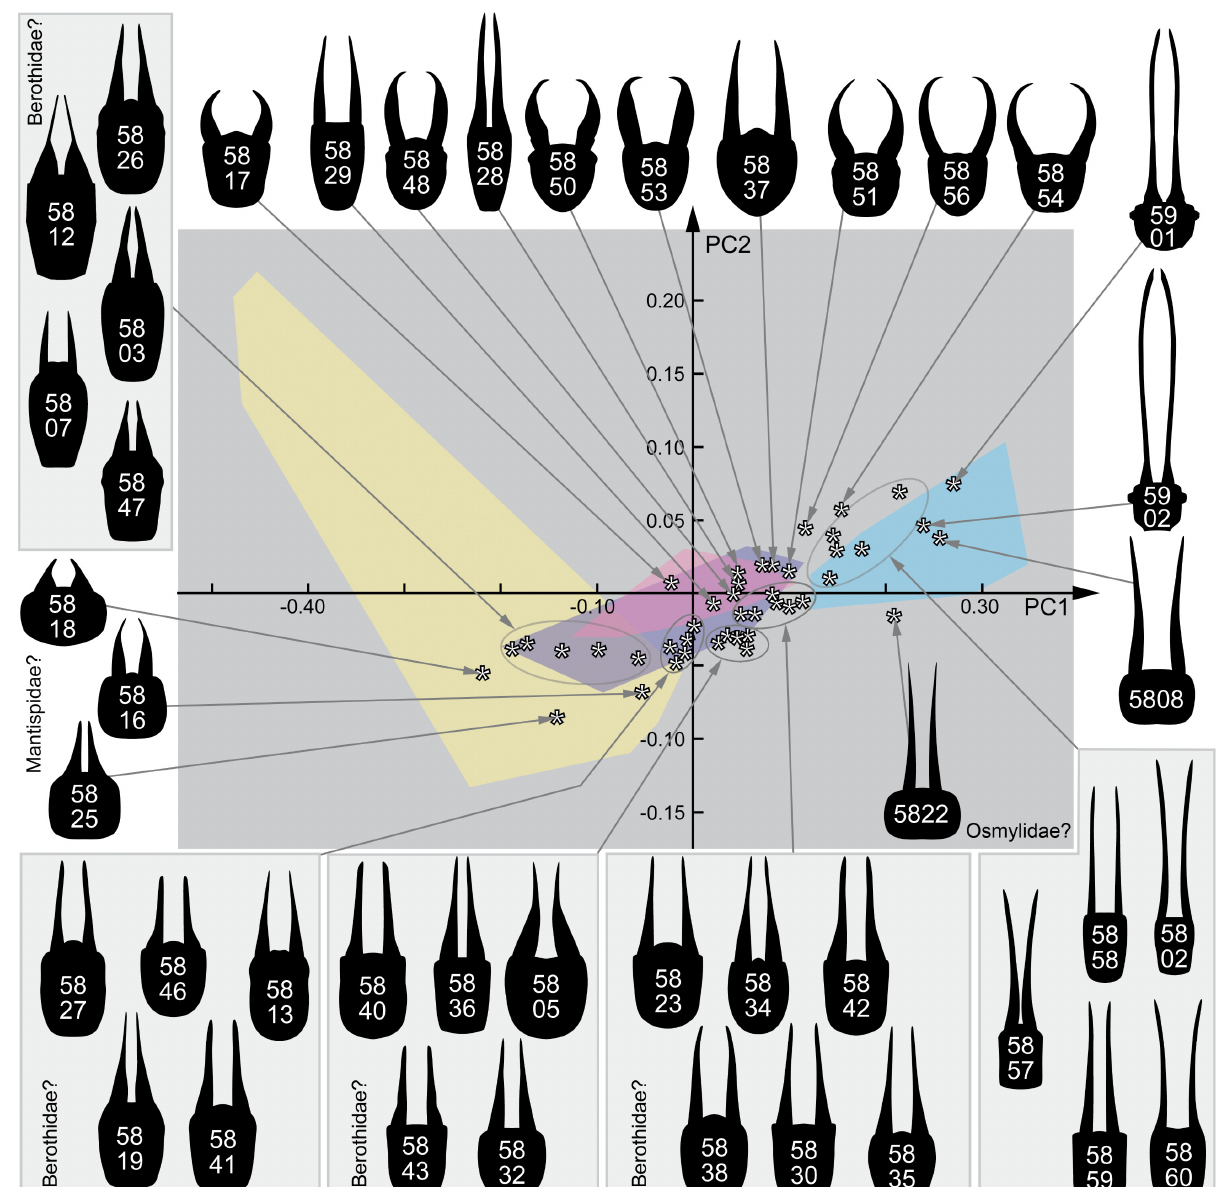
Figure 33. Scatterplot of PC2 vs. PC1 values of head shapes. Occupied areas of extant larvae marked with the same colours as in Figure 32. All fossil specimens are shown with their respective reconstructed outlines. Possible group affinities for some specimens are